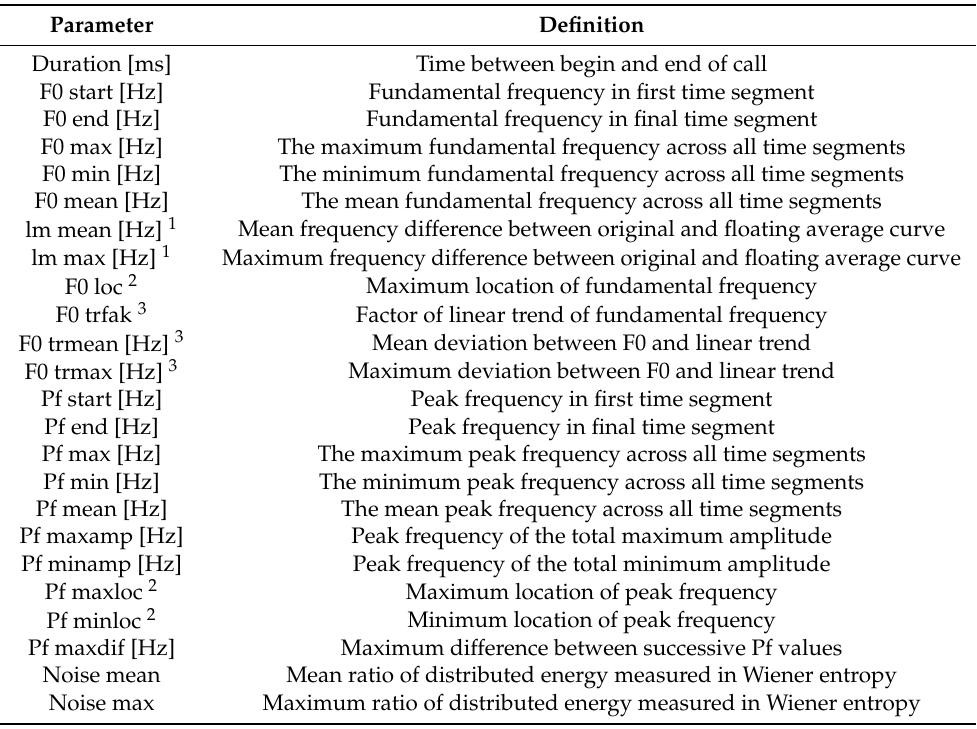
Table 2. Description of the 24 acoustic parameters measured in harmonic